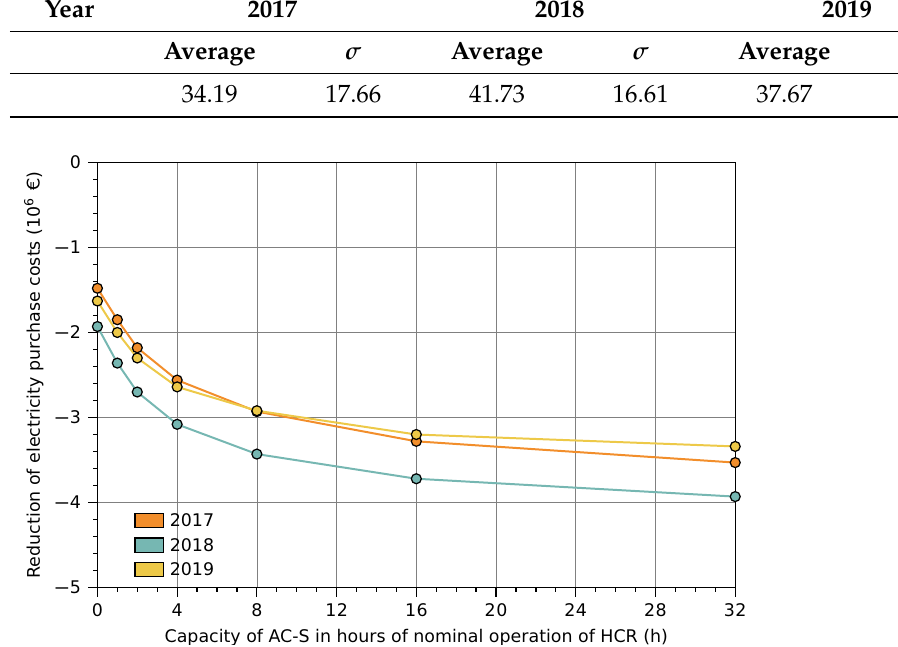
Figure 6. DR savings without balancing power service, 120MW, 2017–2019. Spot prices from the EMMA model present comparably low volatility with a price spread of 3 e /MWh compared to the historic spot price spread of 12 e /MWh in 2016 [21], thus offering less economic incentive for DR, which could be shown by simulating DR operation with historical and modelled (EMMA) spot prices from 2016. For future pre- dictions in Figure 7, the difference in cost savings based on DR is more significant than on part-load efficiency (2025: 2.17 × 10 6 e , 2030: 2.31 × 10 6 e , 2035: 2.69 × 10 6 e ): with additional storage of 32 h and DR with maximum bid factor, savings can be augmented to 3.38 × 10 6 e in 2025, 4.72 × 10 6 e in 2030 and 7.61 × 10 6 e in